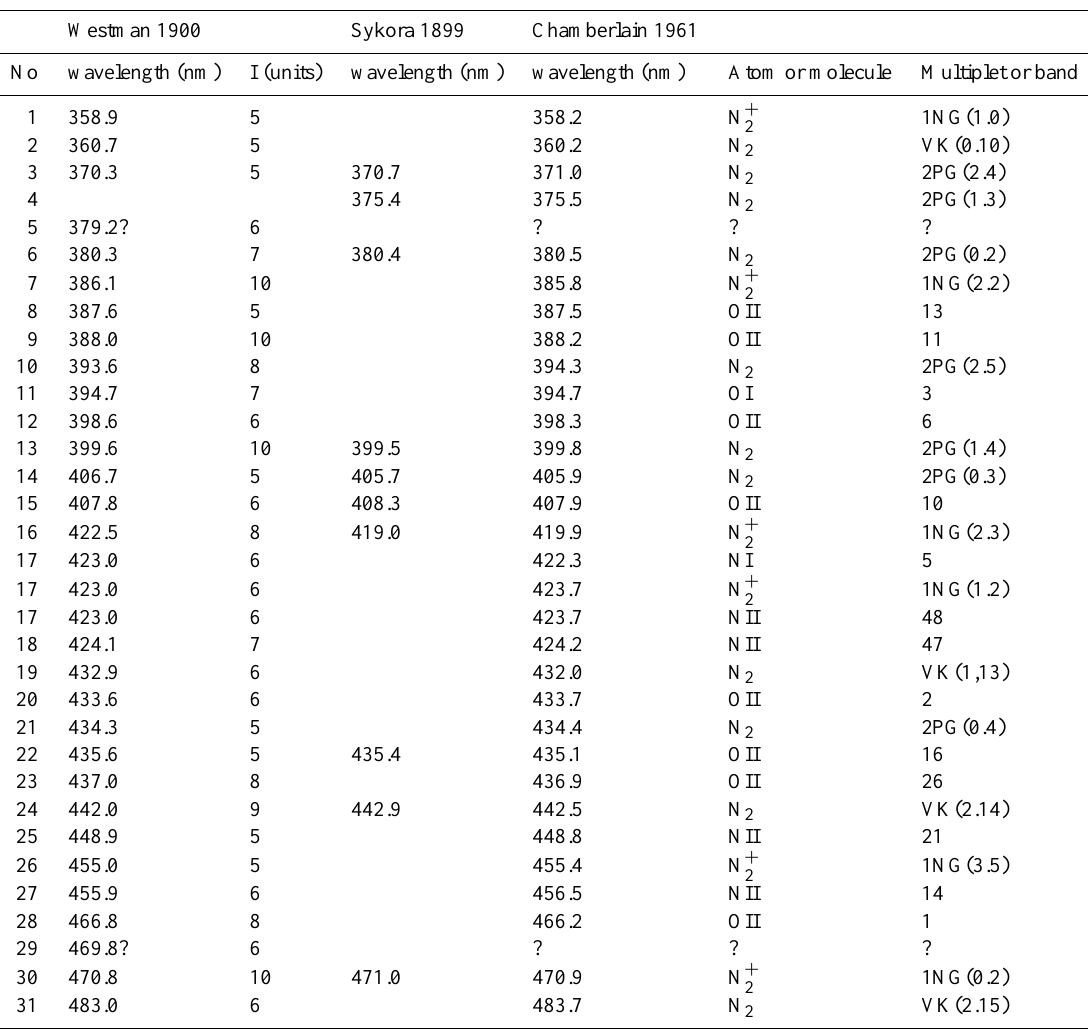
Table 1. Wavelengths of weak auroral spectral lines measured by Westman and Sykora, together with an interpretation of these lines based on data in Chamberlain (1961). For line 17 there are three lines meeting the identification